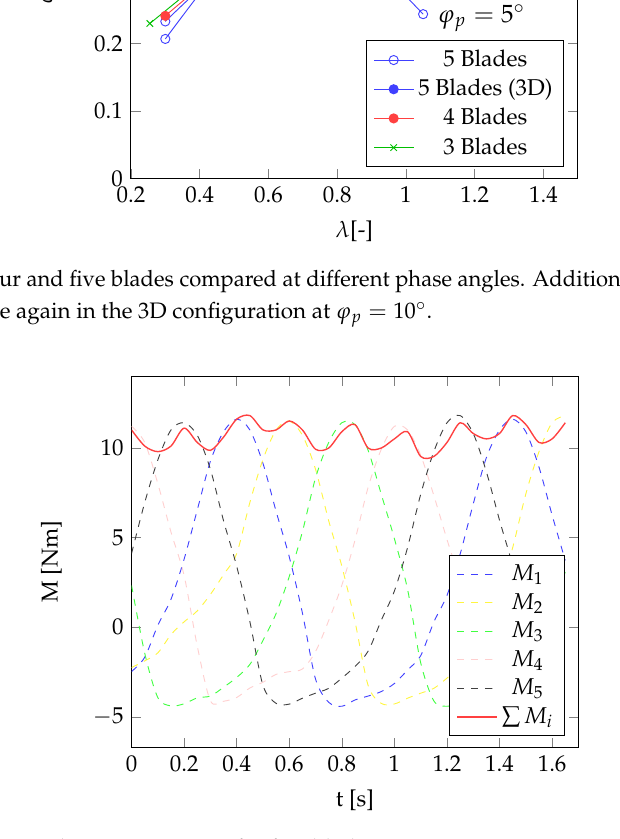
Figure 14. Exemplary torque curve for five blades M i = 1.5 at λ = 0.75 and ϕ p = 10 ◦